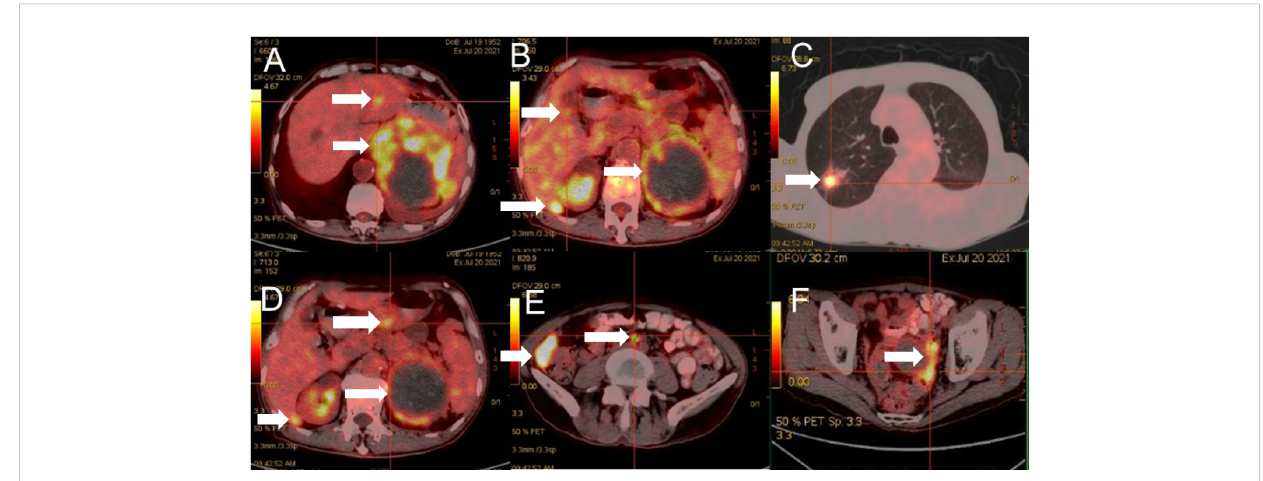
FIGURE 1 Positron emission tomography-CT showed a large, multi-loculated, hypermetabolic, cystic mass in the left adrenal region (A-F)